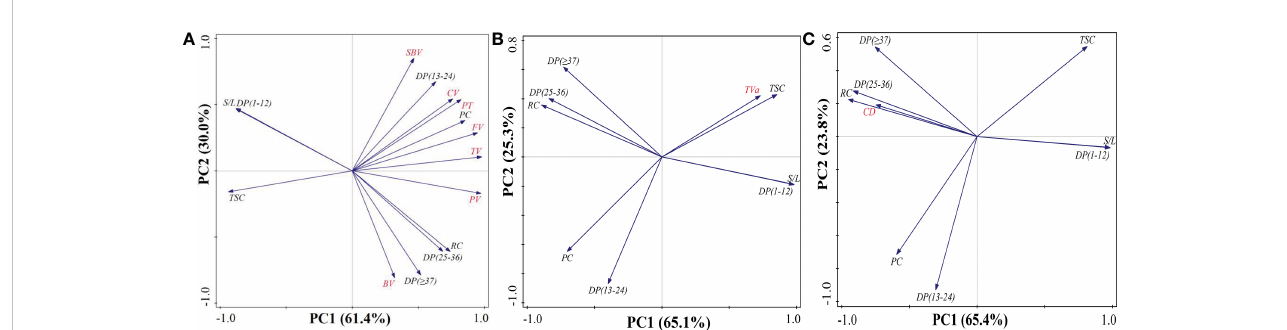
FIGURE 7 The principal components analysis of total starch content, protein content, and starch structure with rice quality including pasting properties (A) , taste value (B) , and grain chalkiness degree (C) . S/L, rate of short chains (DP < 12) to long chains (DP > 12); TSC, total starch content; PC, protein content; SBV, setback viscosity; TV, trough viscosity; BV, breakdown viscosity; FV, fi nal viscosity; CV, consistence viscosity; PT, pasting temperature; DP, degree of polymerization; RC, relative crystallinity; TVa, taste value; CD, chalkiness degree.